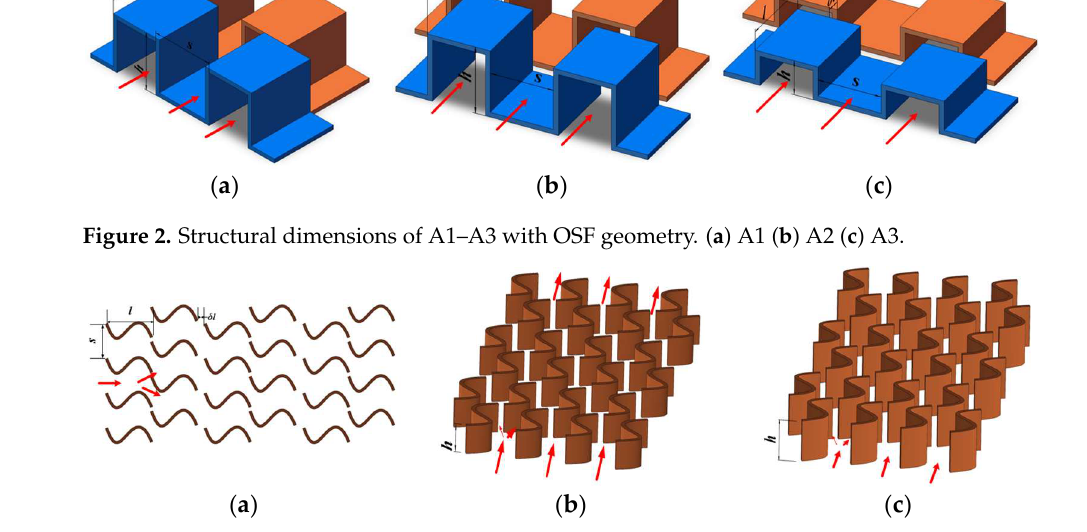
Figure 3. Structural dimensions of A4 and A5 with WF geometry. ( a ) Front view ( b ) A4 ( c ) A5. Table 2. Structural dimensions of internal channels. Figure 2. Structural dimensions of A1–A3 with OSF geometry. ( a ) A1 ( b ) A2 ( c ) A3.